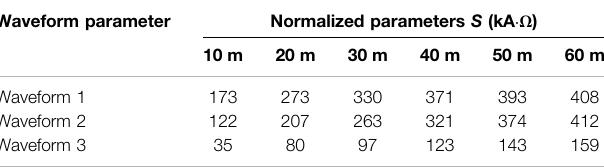
TABLE 9 | Critical value of normalized parameters on which dominant inductance effect switch to dominant spark discharge effect. Waveform